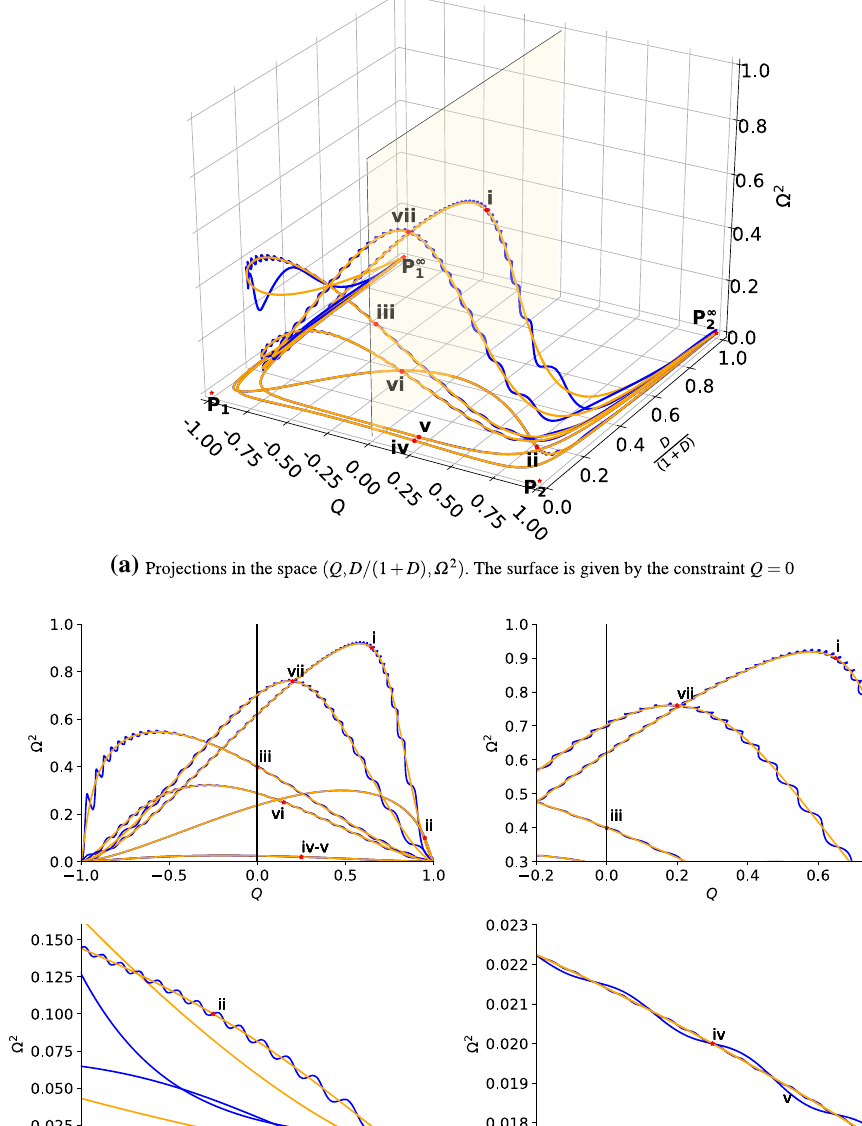
Fig. 18 Some solutions of the full system (93) (blue) and time-averaged system (127) (orange) for the KS metric when γ = 4 in the projection Σ = 3